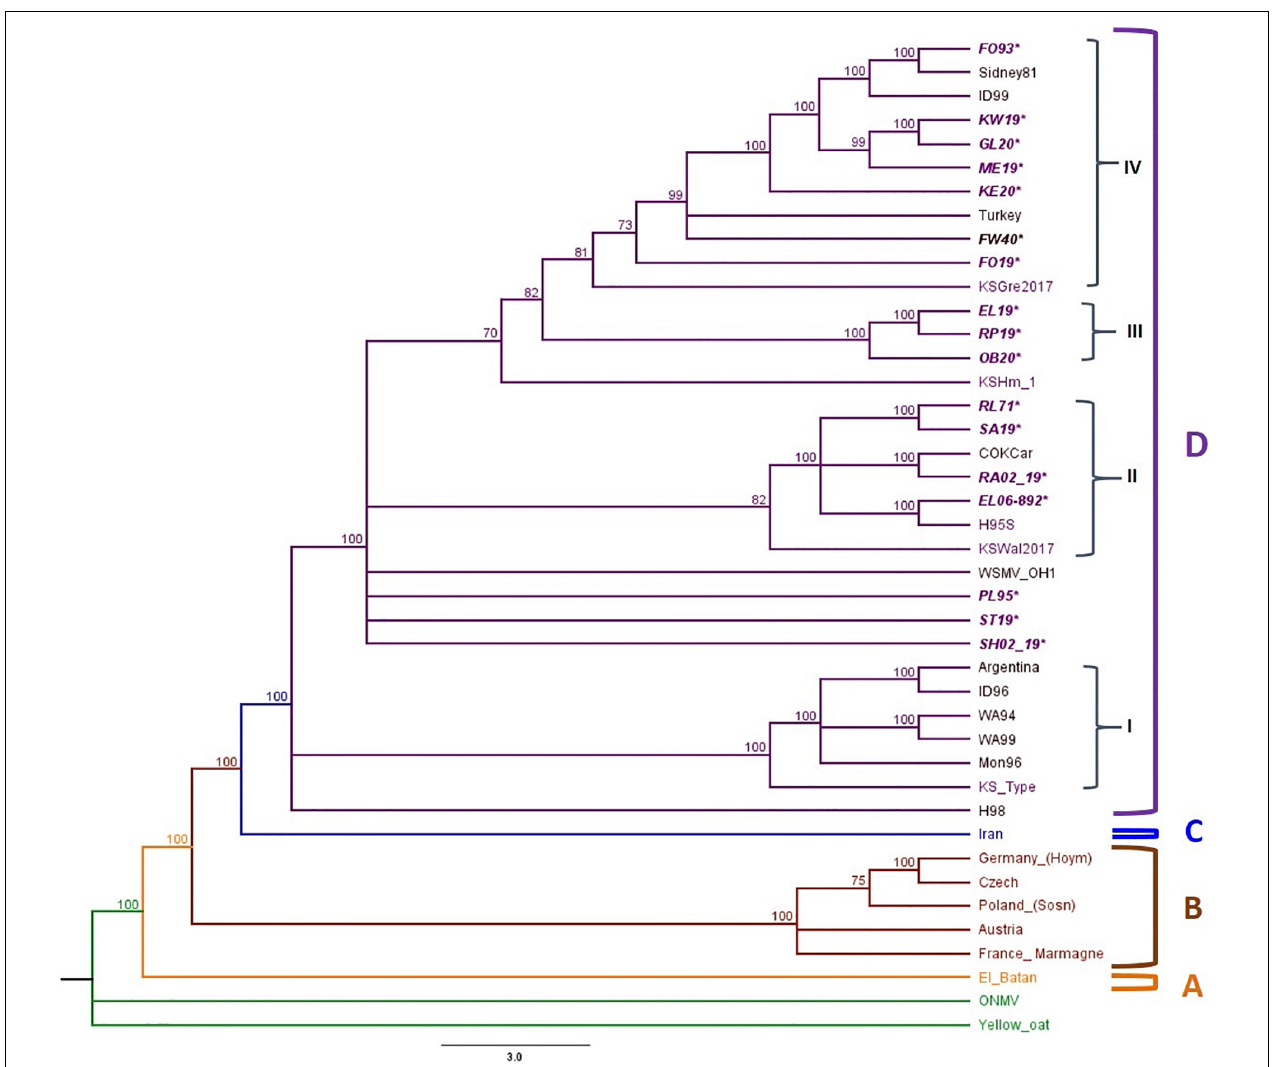
FIGURE 4 | Phylogenetic tree of WSMV isolates is divided into Clades A to C and Clade D is further divided into four sub-clades: I–IV. The sample IDs of Kansas isolates are in purple text, and the isolates sequenced in this study are written in bold and italicized text. The posterior probability of 70% was the cutoff value, and branches not supported were